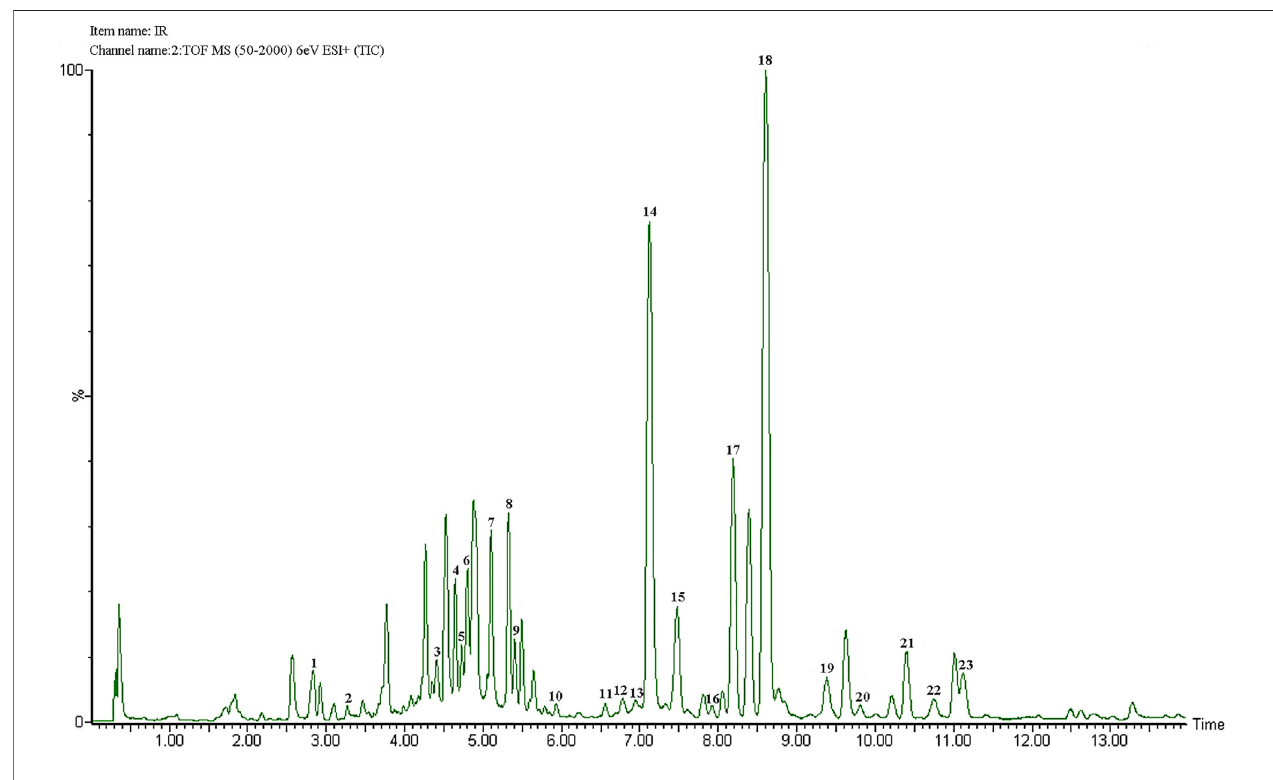
FIGURE 1 | TIC of IR in positive ion